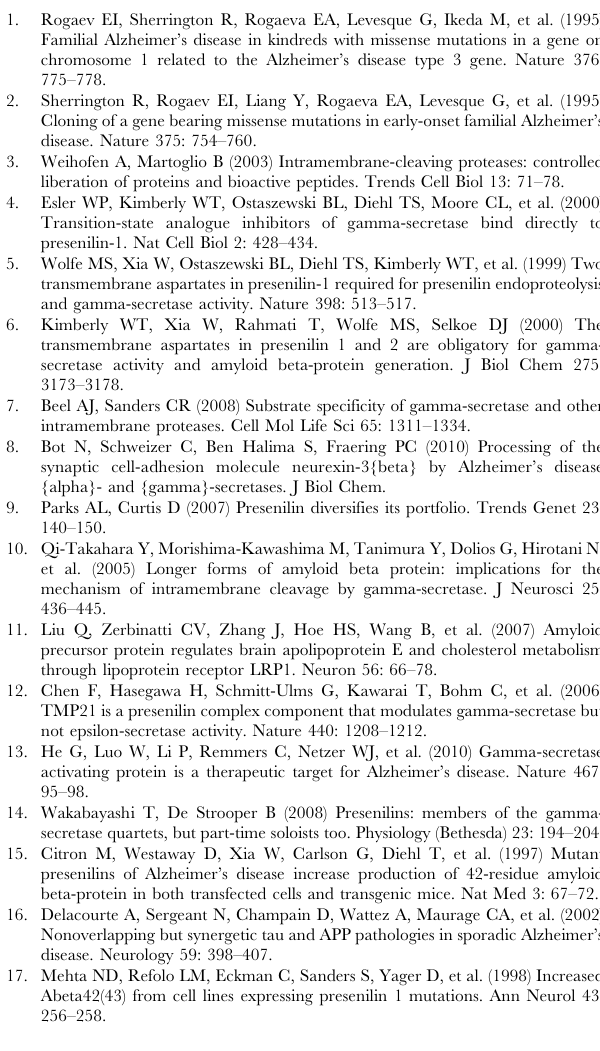
Figure S2 APP-CTF profiles in WT MEF, MEF PS1/2 2 / 2 and c - PS1/2 transduced with the SPA4CT construct.